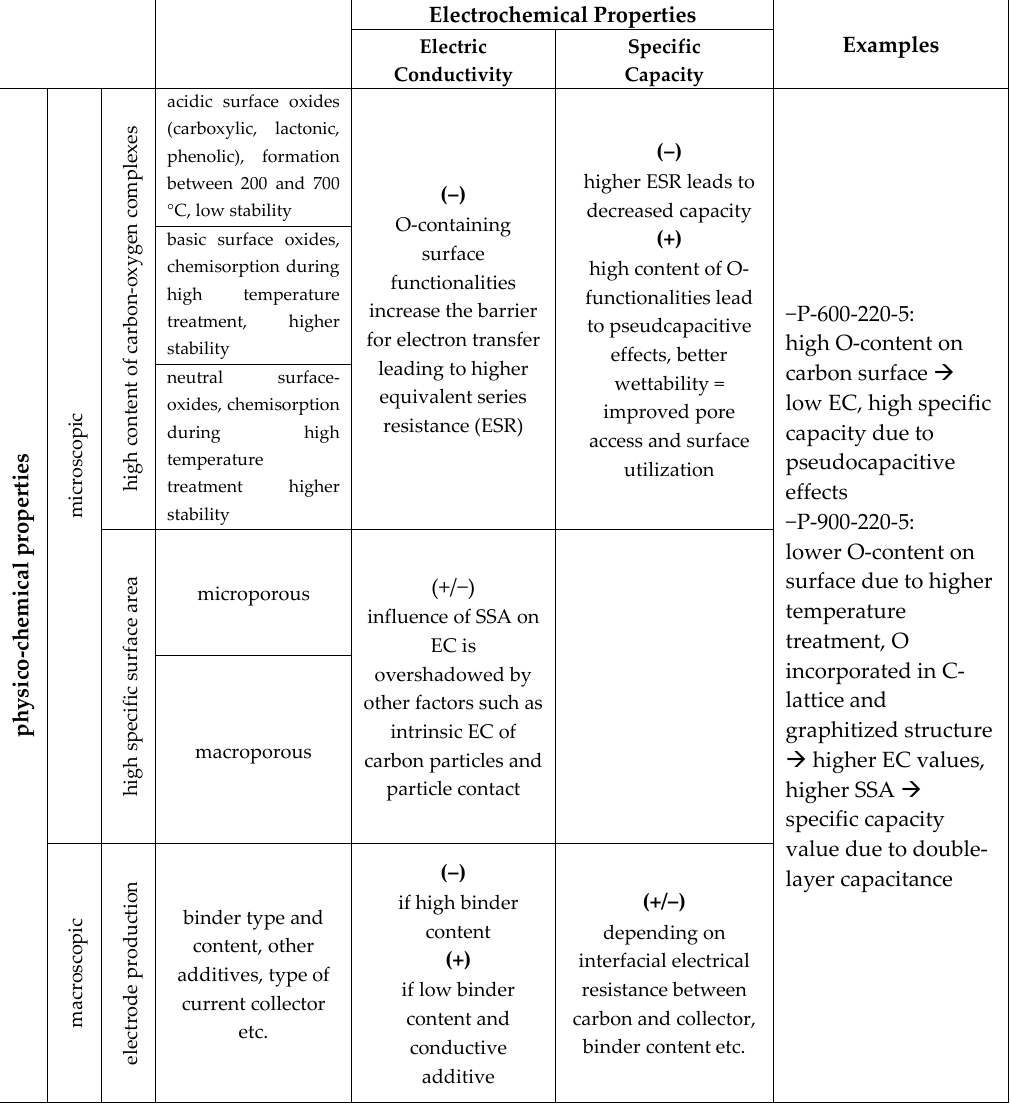
Table 4. Interdependencies between selected physico-chemical and electrochemical properties of advanced carbon materials from biomass ( − = negative impact, + = positive impact, +/ − = no specific impact or impact of minor importance or interaction not fully understood yet) *.